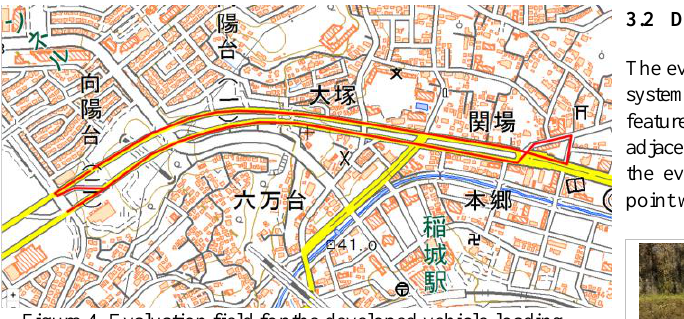
Figure 4. Evaluation field for the developed vehicle-loading system